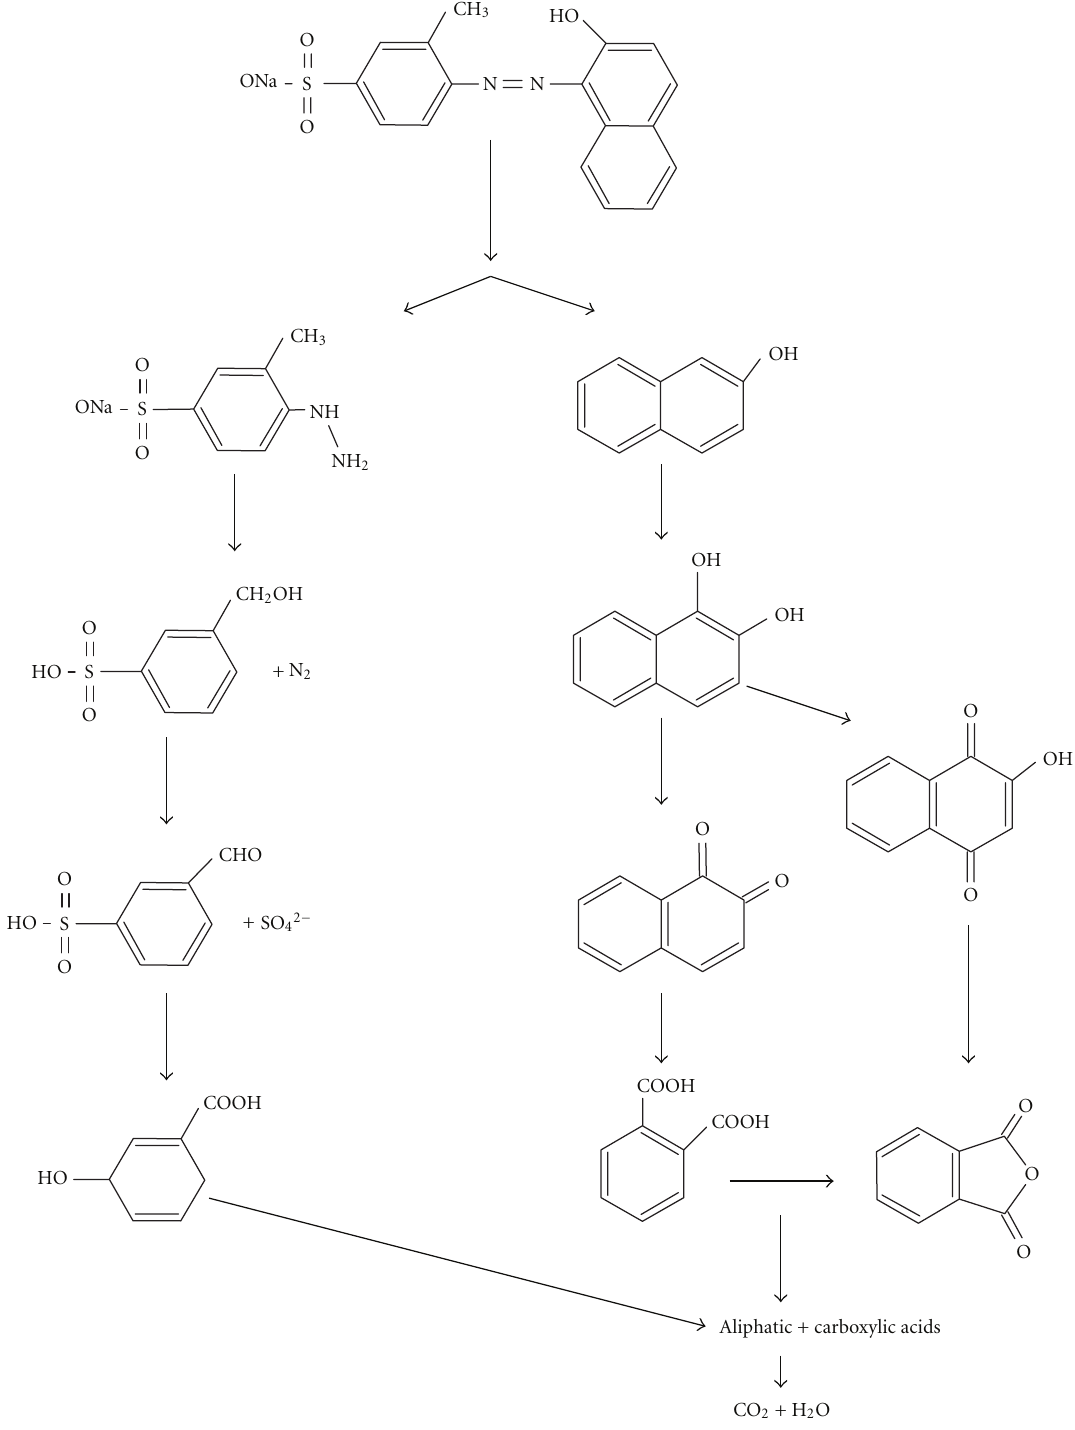
Figure 5: Reaction pathway of photocatalytic degradation of acid Orange